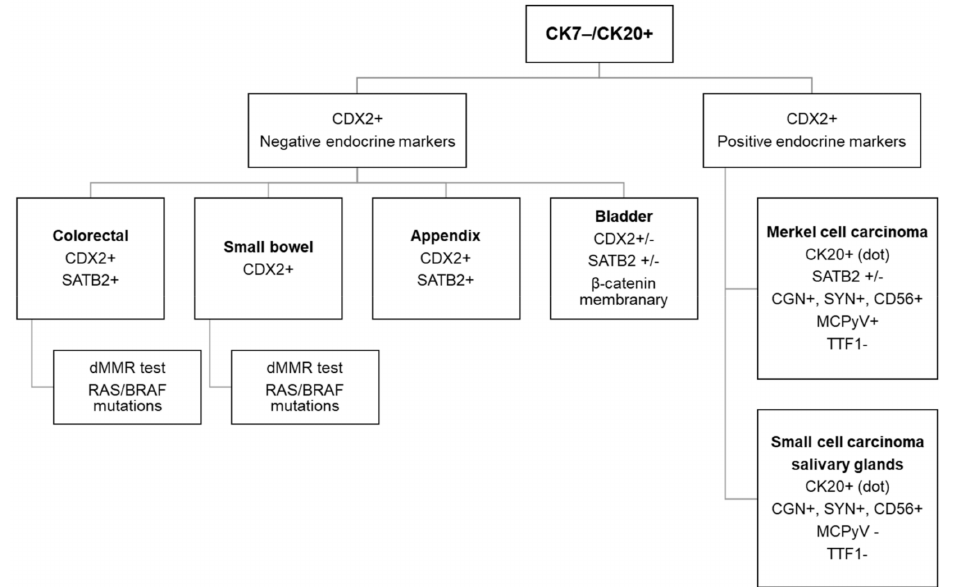
Figure 4. The diagnostic algorithm for workup of a CK7 − /CK20+